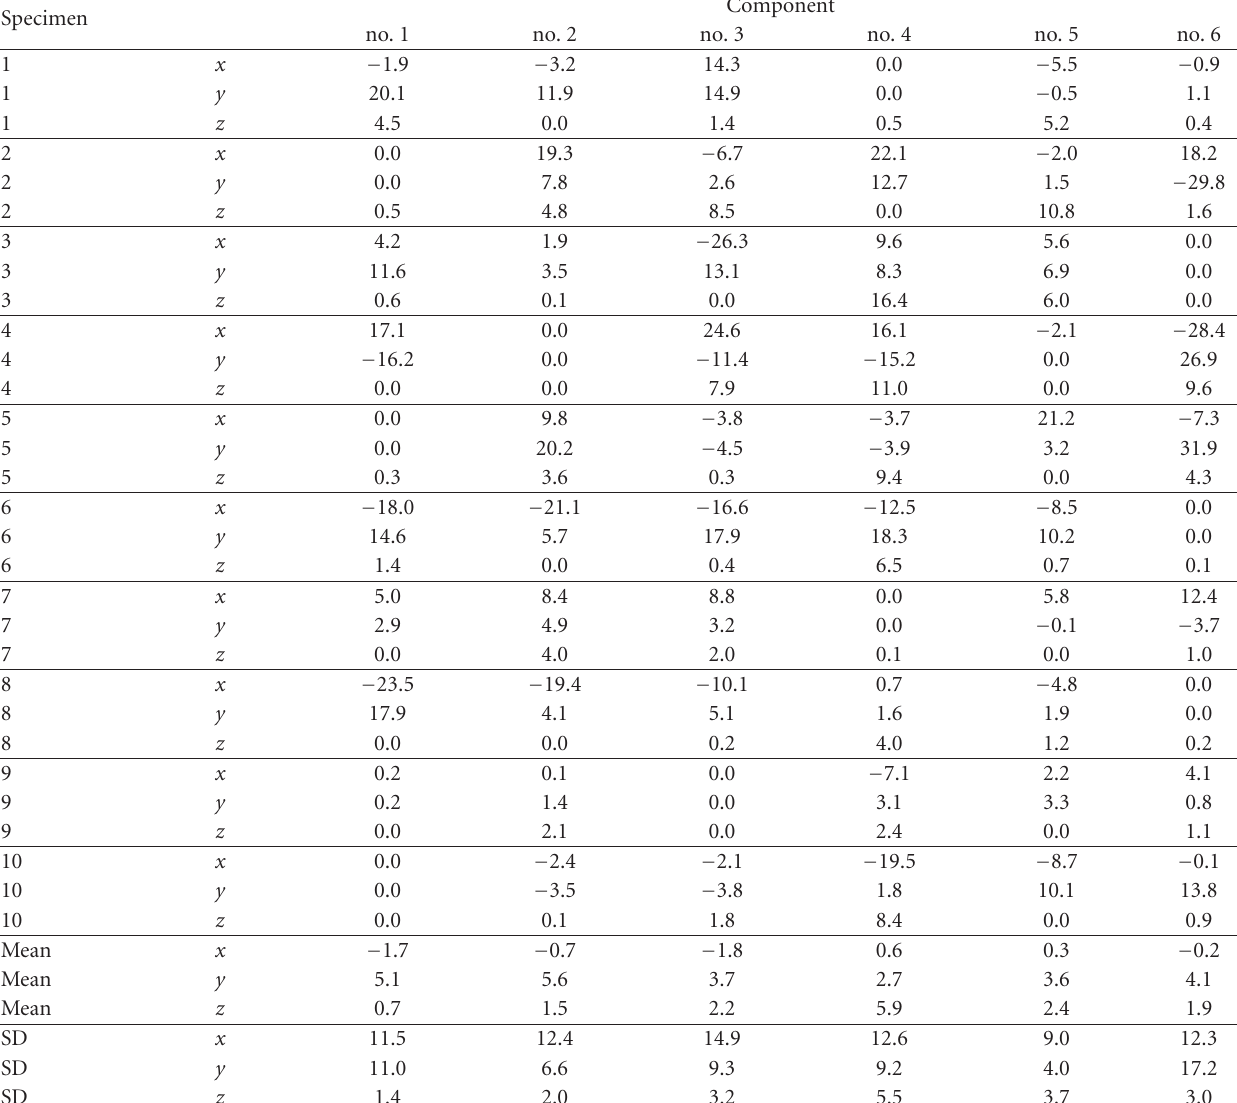
Table 5: The titanium [Test-Master] best-fit di ff erences of each component centroid in µ m.